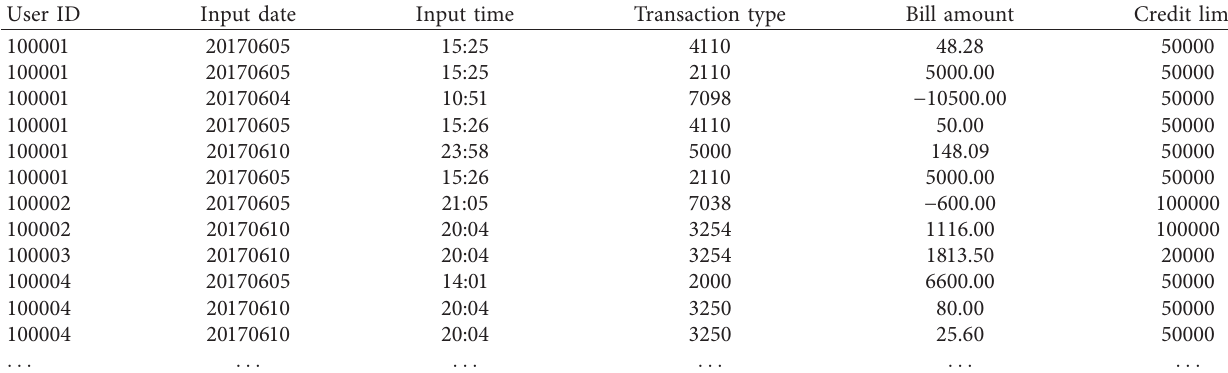
Table 1: Example of transactions flow